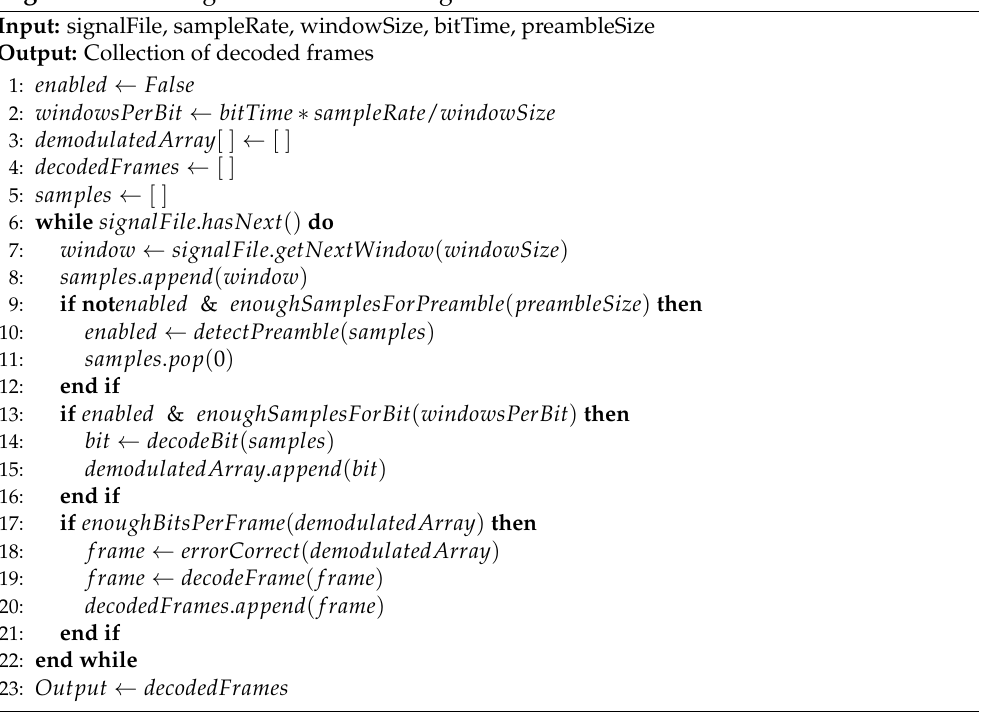
Algorithm 3 EM signal demodulation algorithm